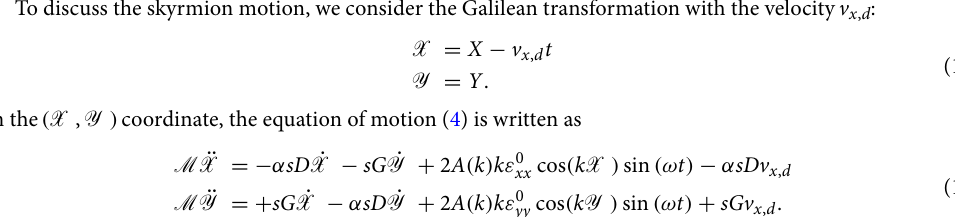
α sDv x , d , sGv x , d ) is We notice that Eq. (12) is equivalent to the equation of motion where a constant force ( − 0 case. The total force thereby consists of the force due to the SAW and additionally added to Eq. (4) in the v x , d = v x , d v x , d the additional force proportional to . If the is less than a certain threshold, the skyrmion stops in the | | | | translational frame. In the original ( X , Y )-coordinate frame, the skyrmion is trapped at antinodes and moves at v x , d almost the same speed as v x , d . In contrast, When the velocity exceeds the threshold, the force proportional | | v x , d to becomes larger than that due to the SAW. In this case, the skymion is no longer trapped at the antinode; | | it jumps over the node of the SAW and moves to the next antinode. The hopping to the next antinode is indicated by the periodic modulation of the skyrmion motion in Fig. 4(c). / T as X X ( t T ) X ( t 0 ) Figure 4(d) shows the velocity of skyrmion motion along the X direction � ˙ � = [ = − = ] (cid:31) f x (cid:31) f x (cid:31) f x X a function of . Here, T is the simulation time. The velocity increases almost linearly with at low | | | | | | � ˙ �